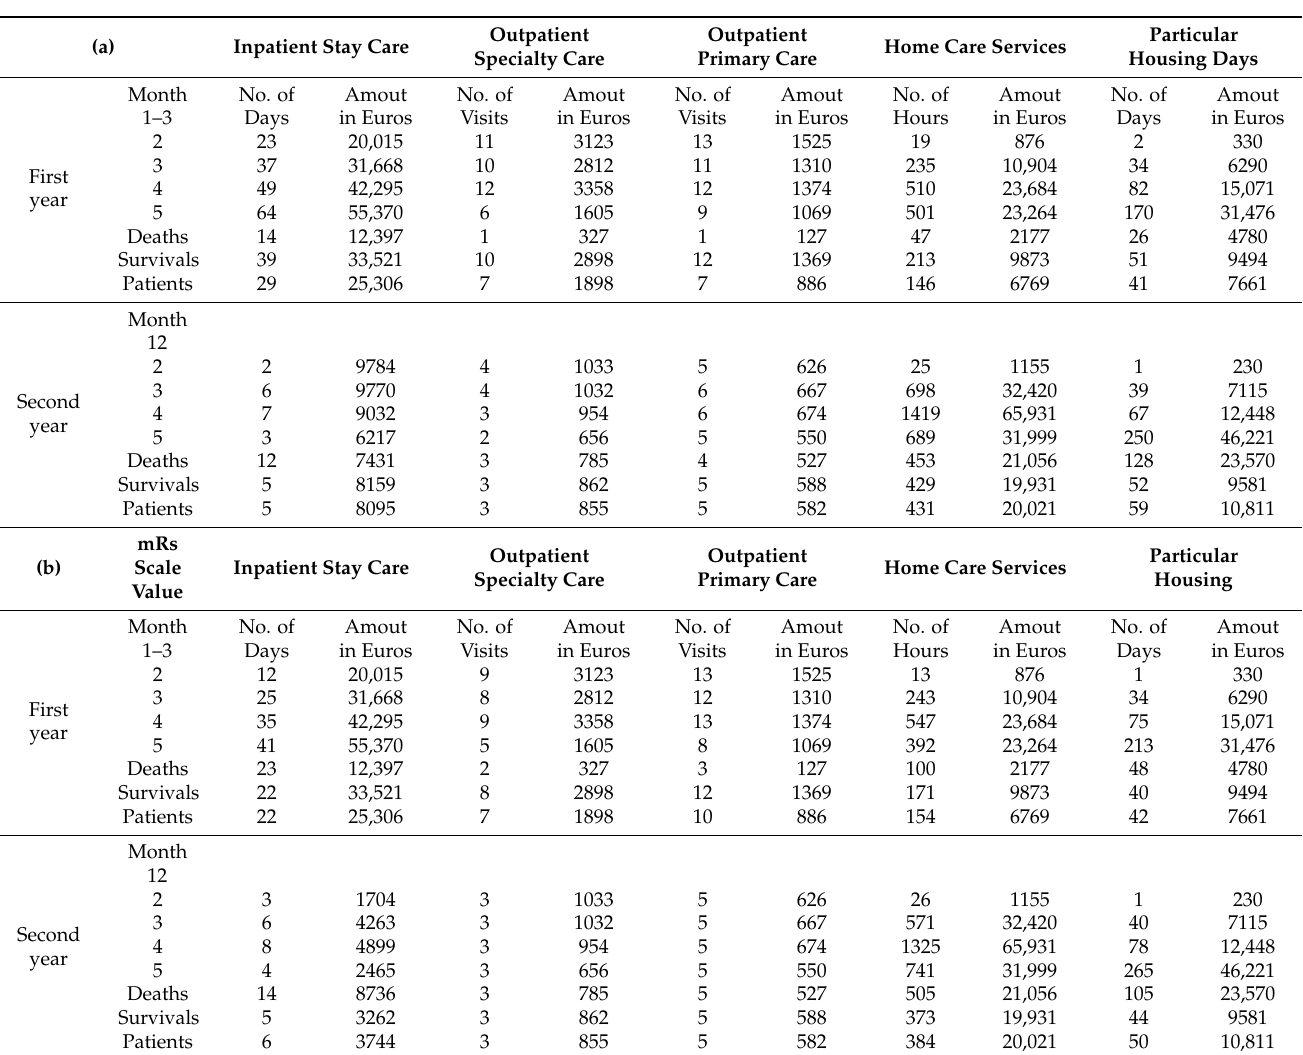
Table 4. First and second year cost analysis per patient according to modified Rankin scale score